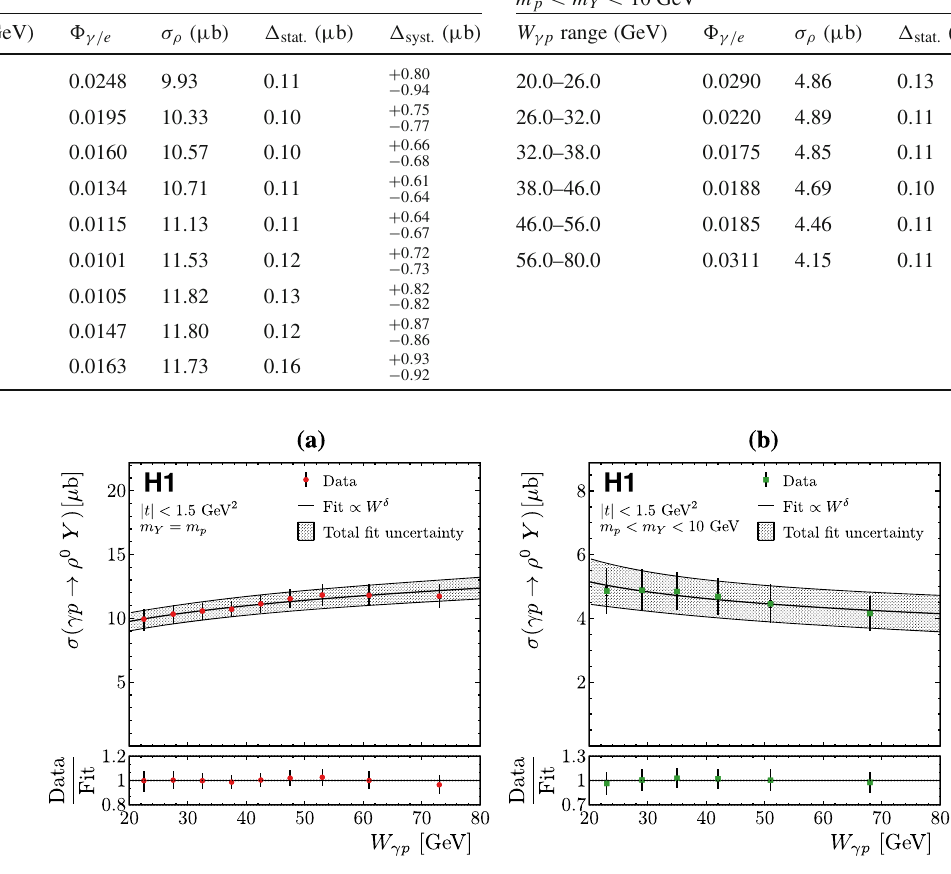
Fig. 10 Elastic ( m Y = m p ) ( a ) and proton-dissociative ( m p < m Y < 10 GeV) ( b ) ρ 0 meson photoproduction cross sections σ(γ p → ρ 0 Y ) as functions of W γ p . The vertical lines indicate the total uncertainties. The statistical uncertainties are indicated by the inner error bars, which however are mostly covered by the data markers.